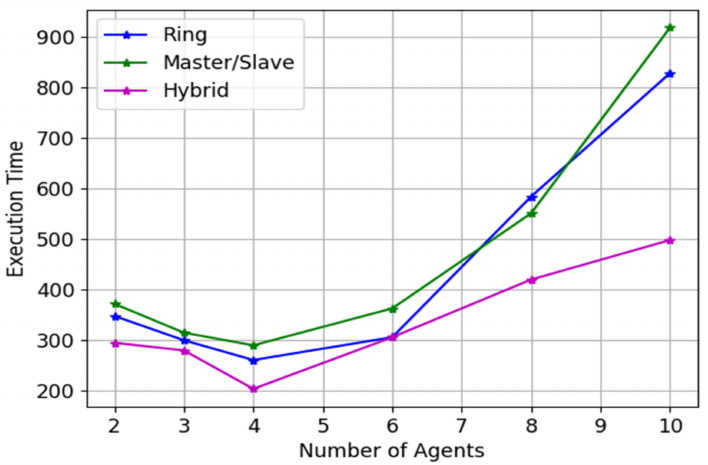
Figure 13. Execution time of different strategy agents (Ring, Master/Slave, and Hybrid).